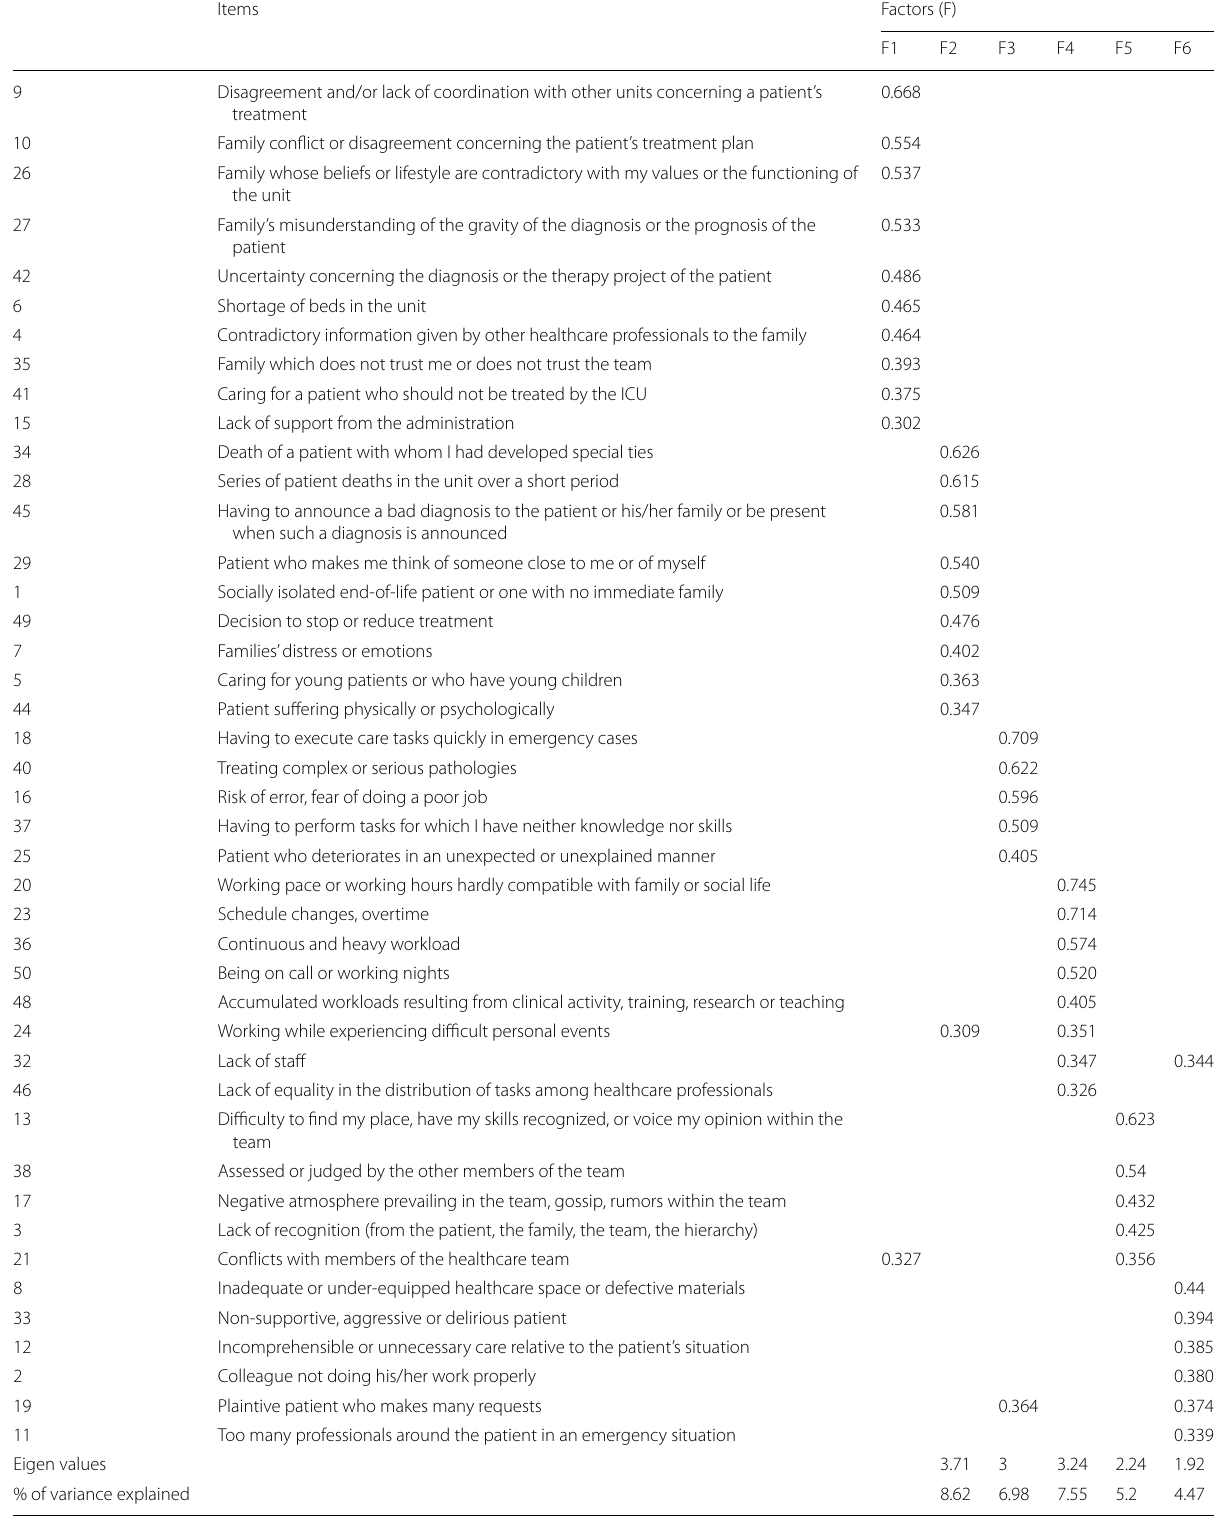
Table 4 Loading of the PS‑ICU scale items from principal axis exploratory factor analysis with Oblimin direct rotation (items #14, #22, #30, #31, #39, #43 and #47 were preliminarily